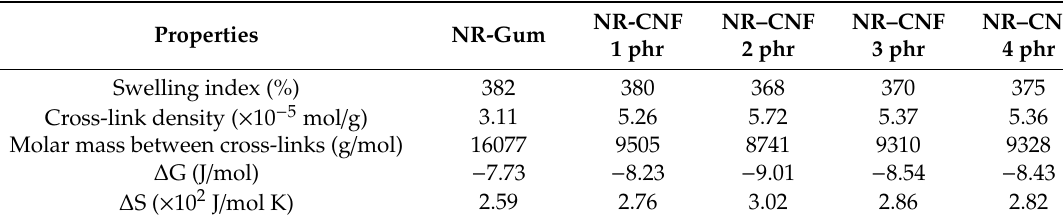
Figure 6. Q t vs. t 1 / 2 plot of NR gum and NR–CNF 4 phr nanocomposites. Table 5. Sorption parameters of NR–CNF nanocomposites.